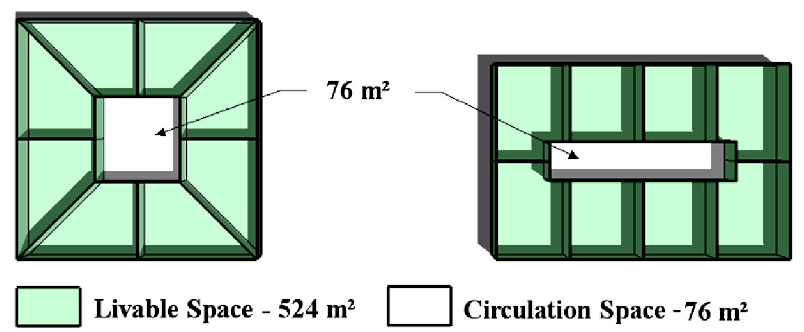
Figure 7. Model floor plans have consistent livable and circulation space and are representative of typical modern multi-unit residential building (MURB)